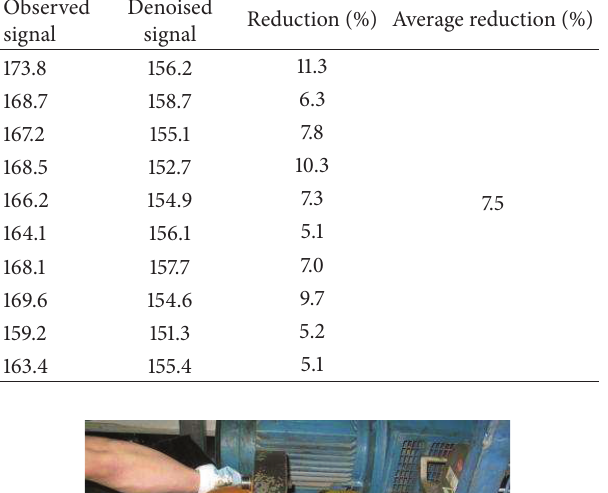
Table 4: The denoised maximum rotation speed.